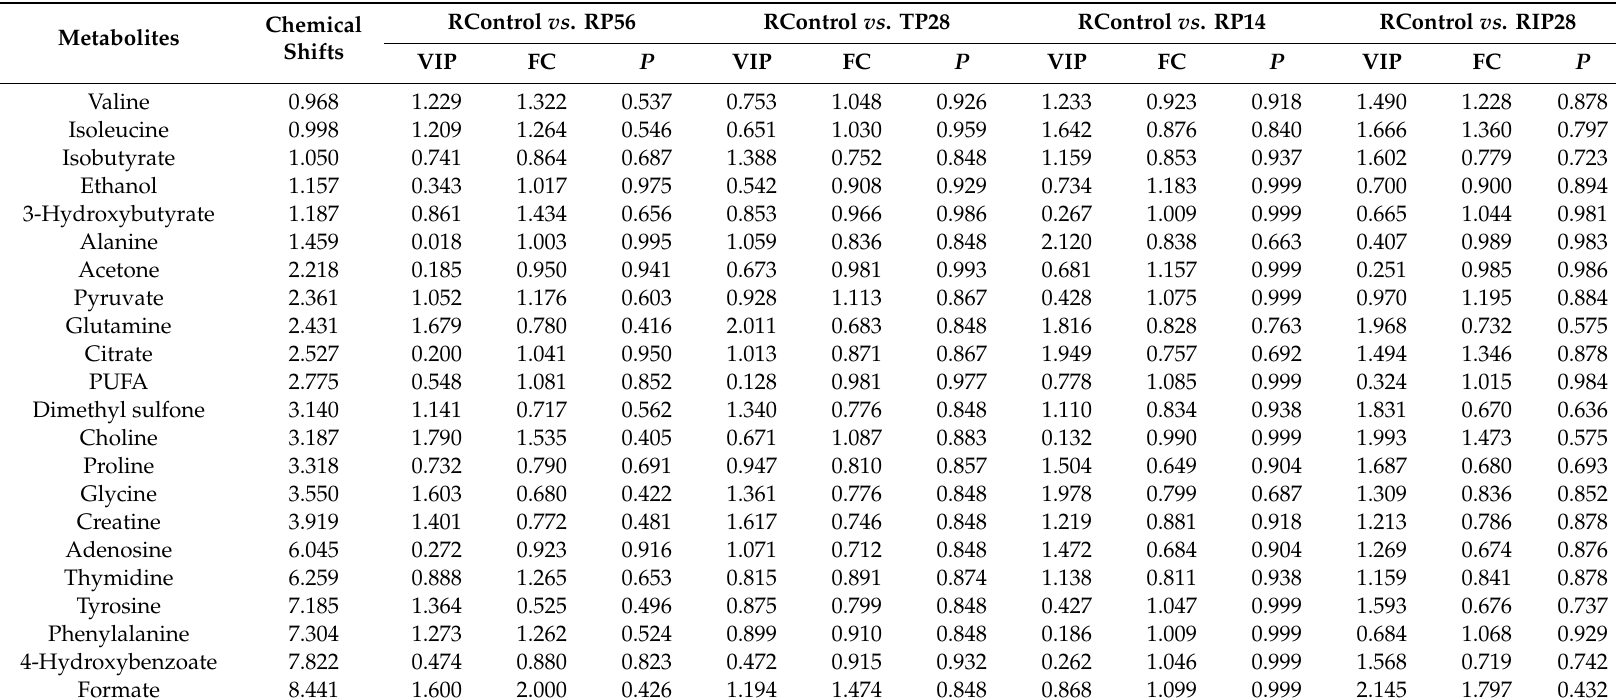
Table 6. The VIP, fold change and P values of 22 di ff erential metabolites in recovery